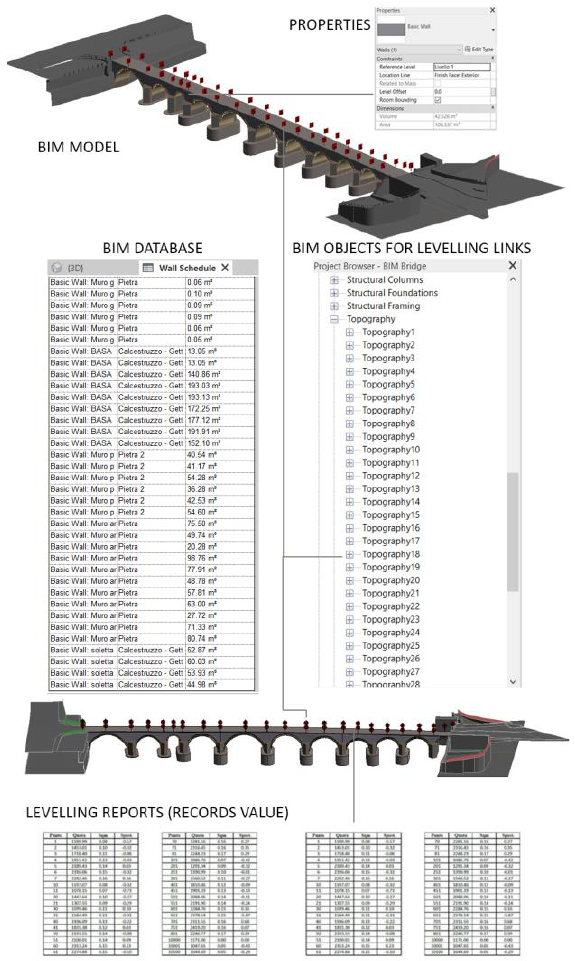
Figure 7. Azzone Visconti bridge's BIM linked to new ‘levelling BIM